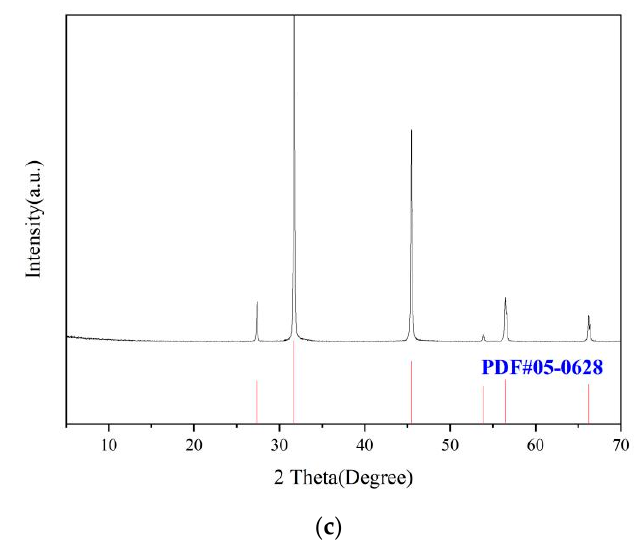
Figure 10. ( a ) XRD results of calcium bentonite (35 KV (30 mA) − 1 , 8 °min − 1 , 0.02 °step − 1 ), ( b ) main chemical components of calcium bentonite, ( c ) XRD results of sea salt (35 KV (30 mA) − 1 , 8 °min − 1 , 0.02 °step − 1 )